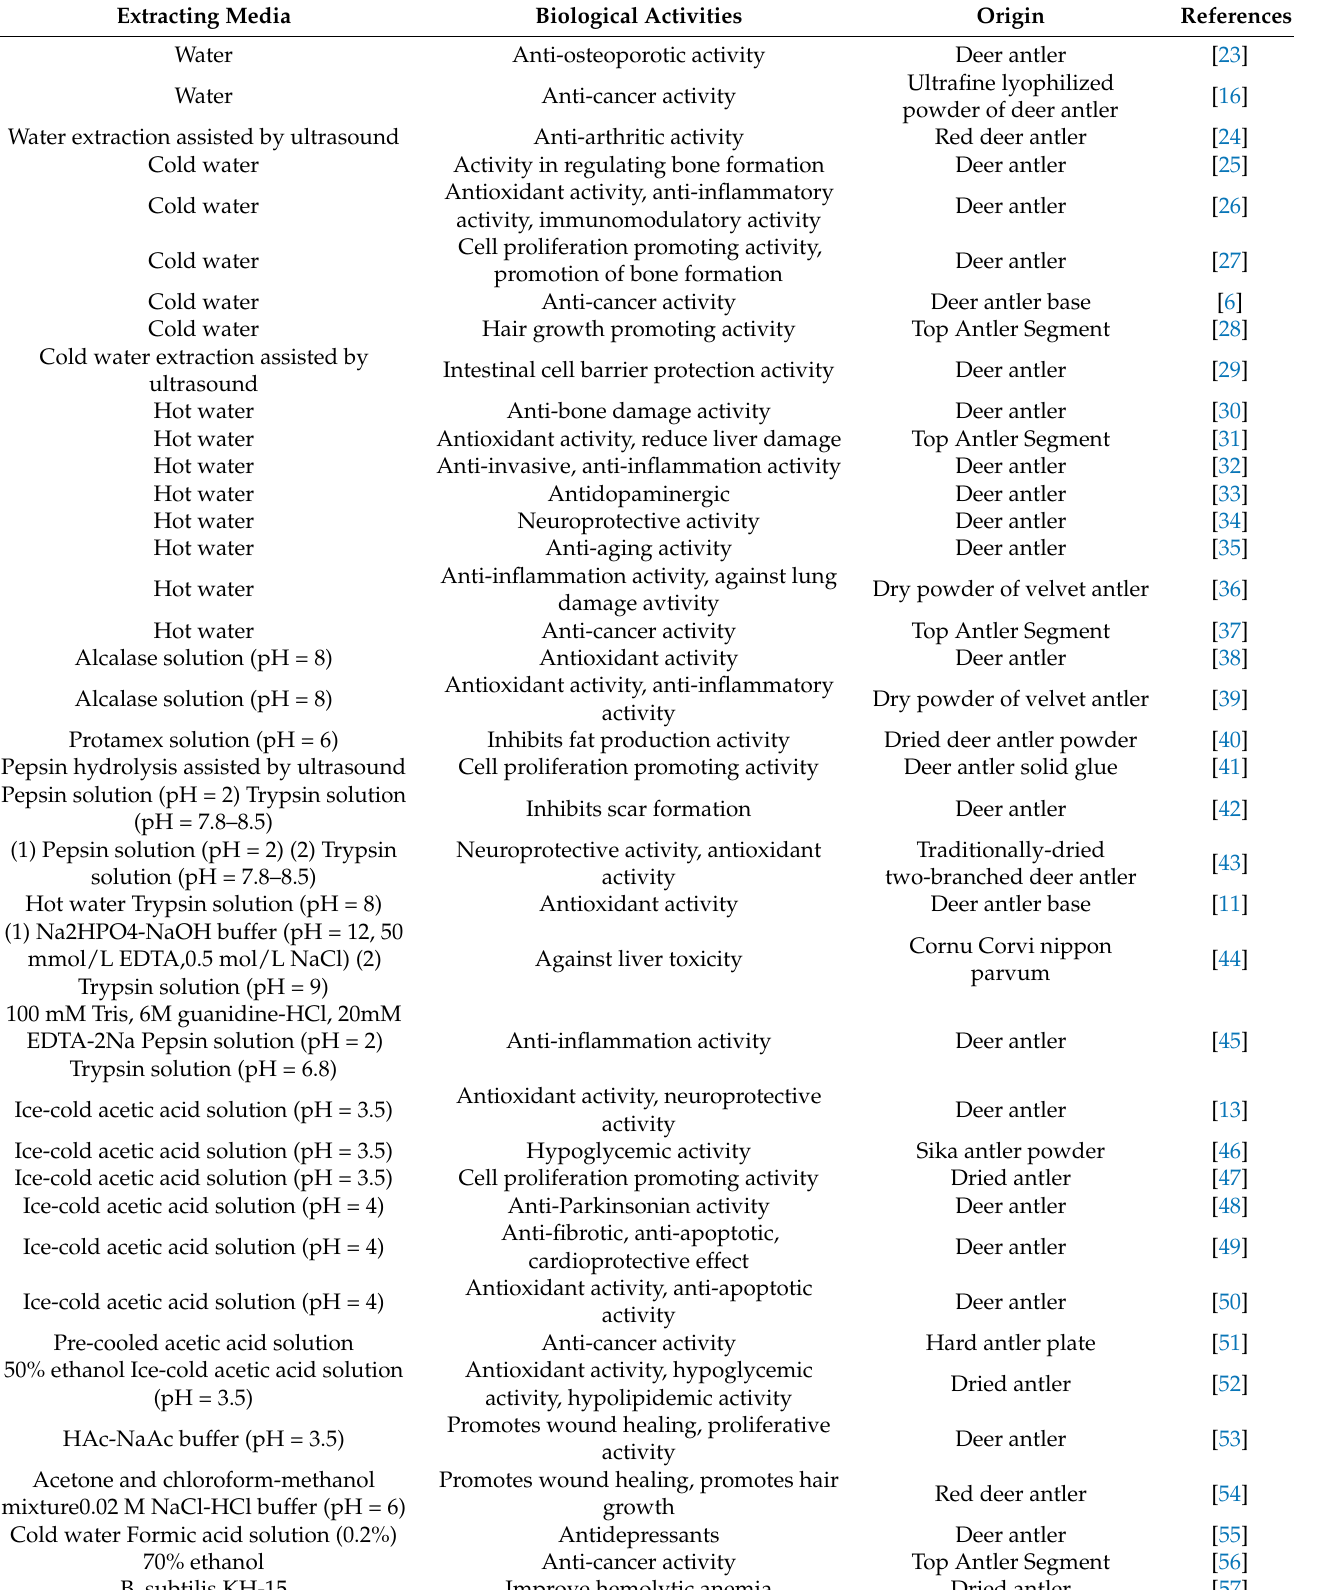
Table 2. Extraction method and biological activity of